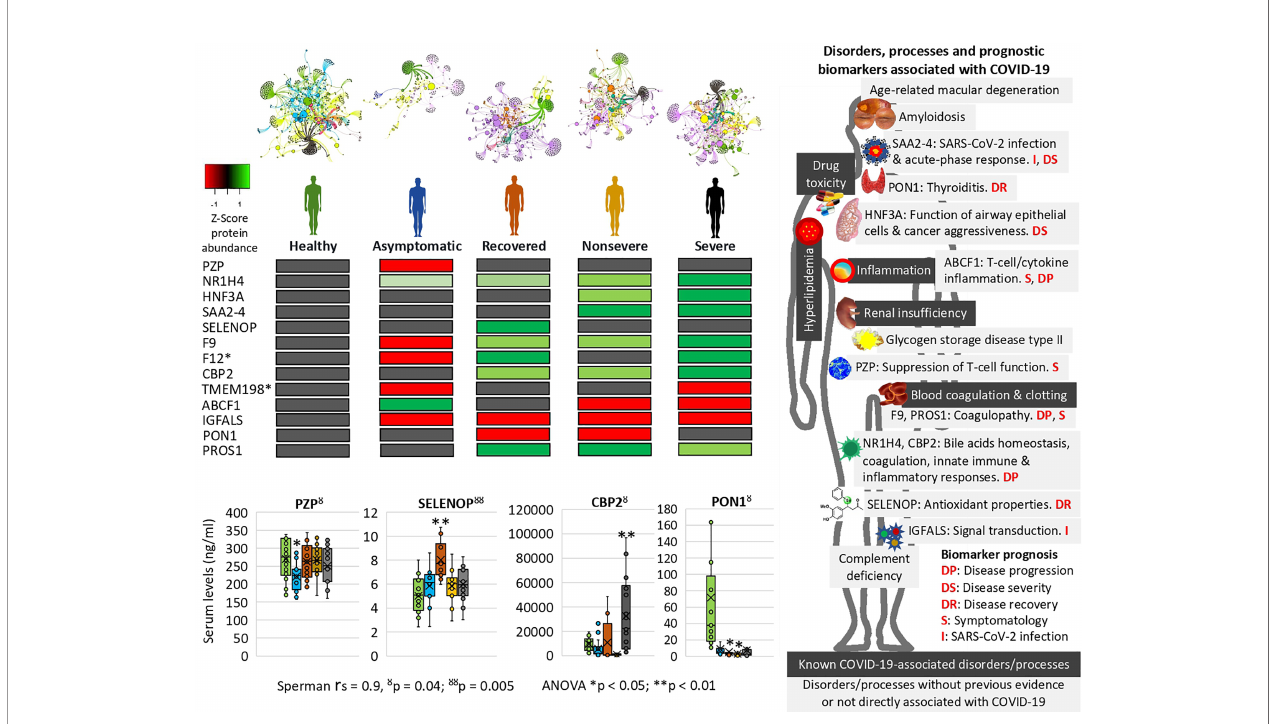
FIGURE 7 | Prognostic biomarker proteins related to COVID-19 symptomatology. Network analysis of interactions between proteins and BPs re fl ects nestedness or structuring of the cluster ’ s magnitude decreasing with COVID-19 symptomatology. SWATH-MS quantitative serum proteomics identi fi ed proteins involved in physiological disorders and processes associated with COVID-19 and novel biomarker proteins with potential implications for the development of new diagnostic and therapeutic interventions to contribute to the control of this pandemic. *Unsupportive protein pro fi le for prognostic biomarker. Selected serum biomarkers (PZP, SELENOP, CBP2, and PON1) were validated by ELISA. Change in protein serum levels with signi fi cant differences in comparison to healthy controls (* p < 0.05, ** p < 0.01; one-way ANOVA test with post-hoc Tukey HSD). Proteomics and ELISA data were compared by Spearman ’ s Rho (rs) correlation analysis ( ŏ p < 0.05, ŏŏ p <